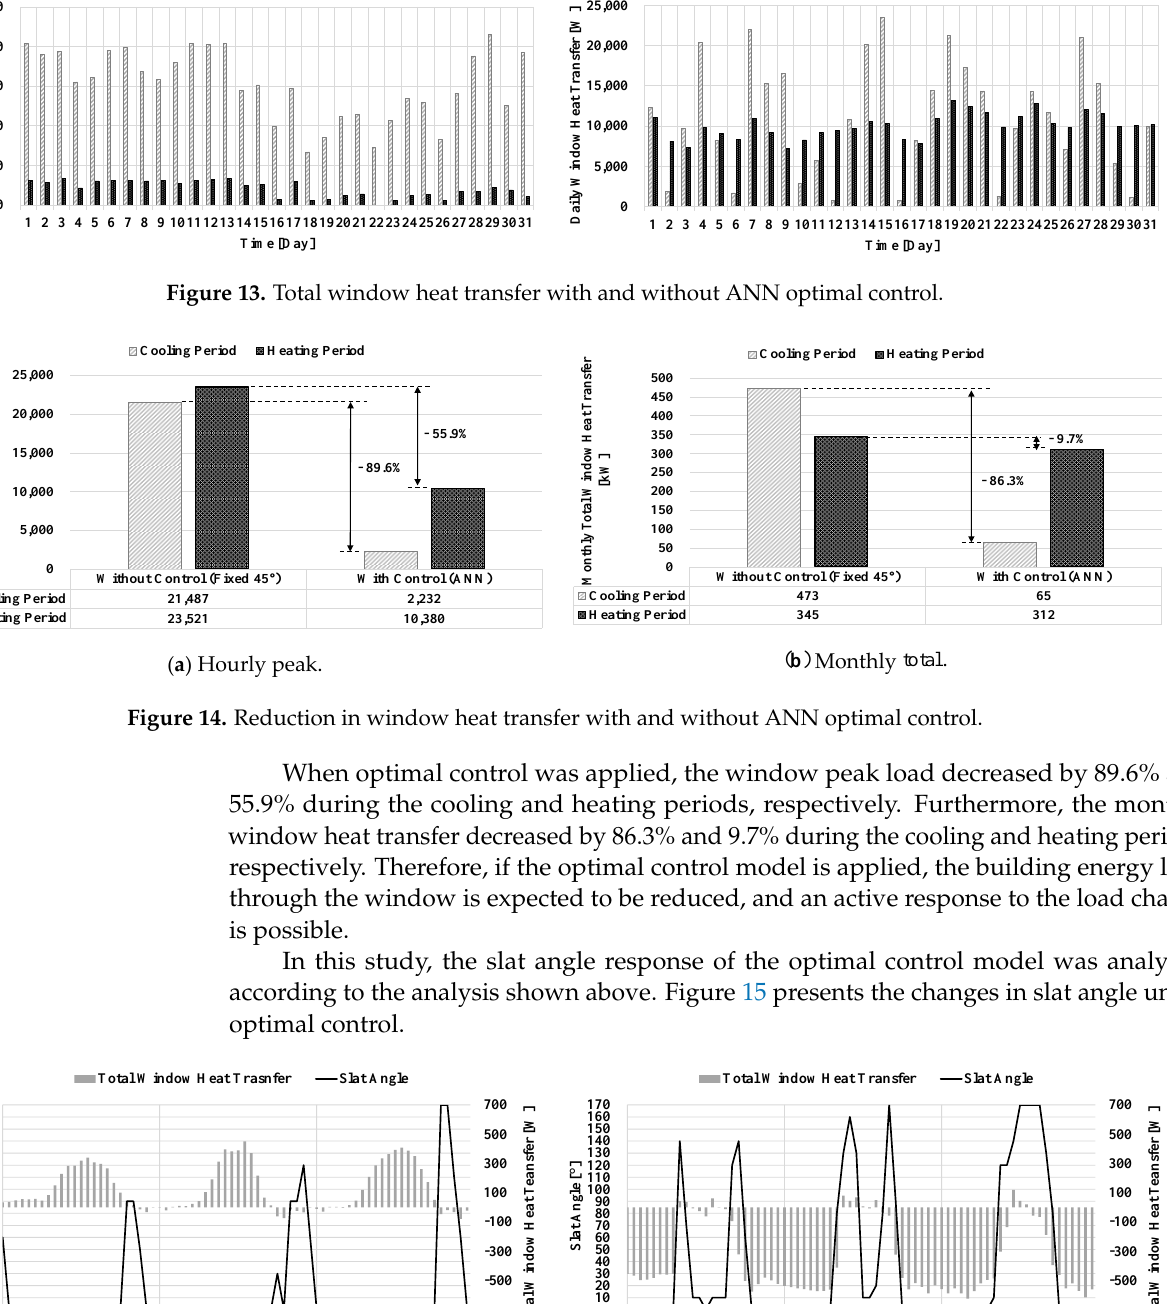
Figure 14. Reduction in window heat transfer with and without ANN optimal control. When optimal control was applied, the window peak load decreased by 89.6% and 55.9% during the cooling and heating periods, respectively. Furthermore, the monthly window heat transfer decreased by 86.3% and 9.7% during the cooling and heating peri- ods, respectively. Therefore, if the optimal control model is applied, the building energy load through the window is expected to be reduced, and an active response to the load change is possible. In this study, the slat angle response of the optimal control model was analyzed ac- cording to the analysis shown above. Figure 15 presents the changes in slat angle under optimal control. Figure 15. Variation in slat angle under ANN optimal control. Figure 15. Variation in slat angle under ANN optimal During the cooling period, the slat angle of the movable shading device was 0° in the